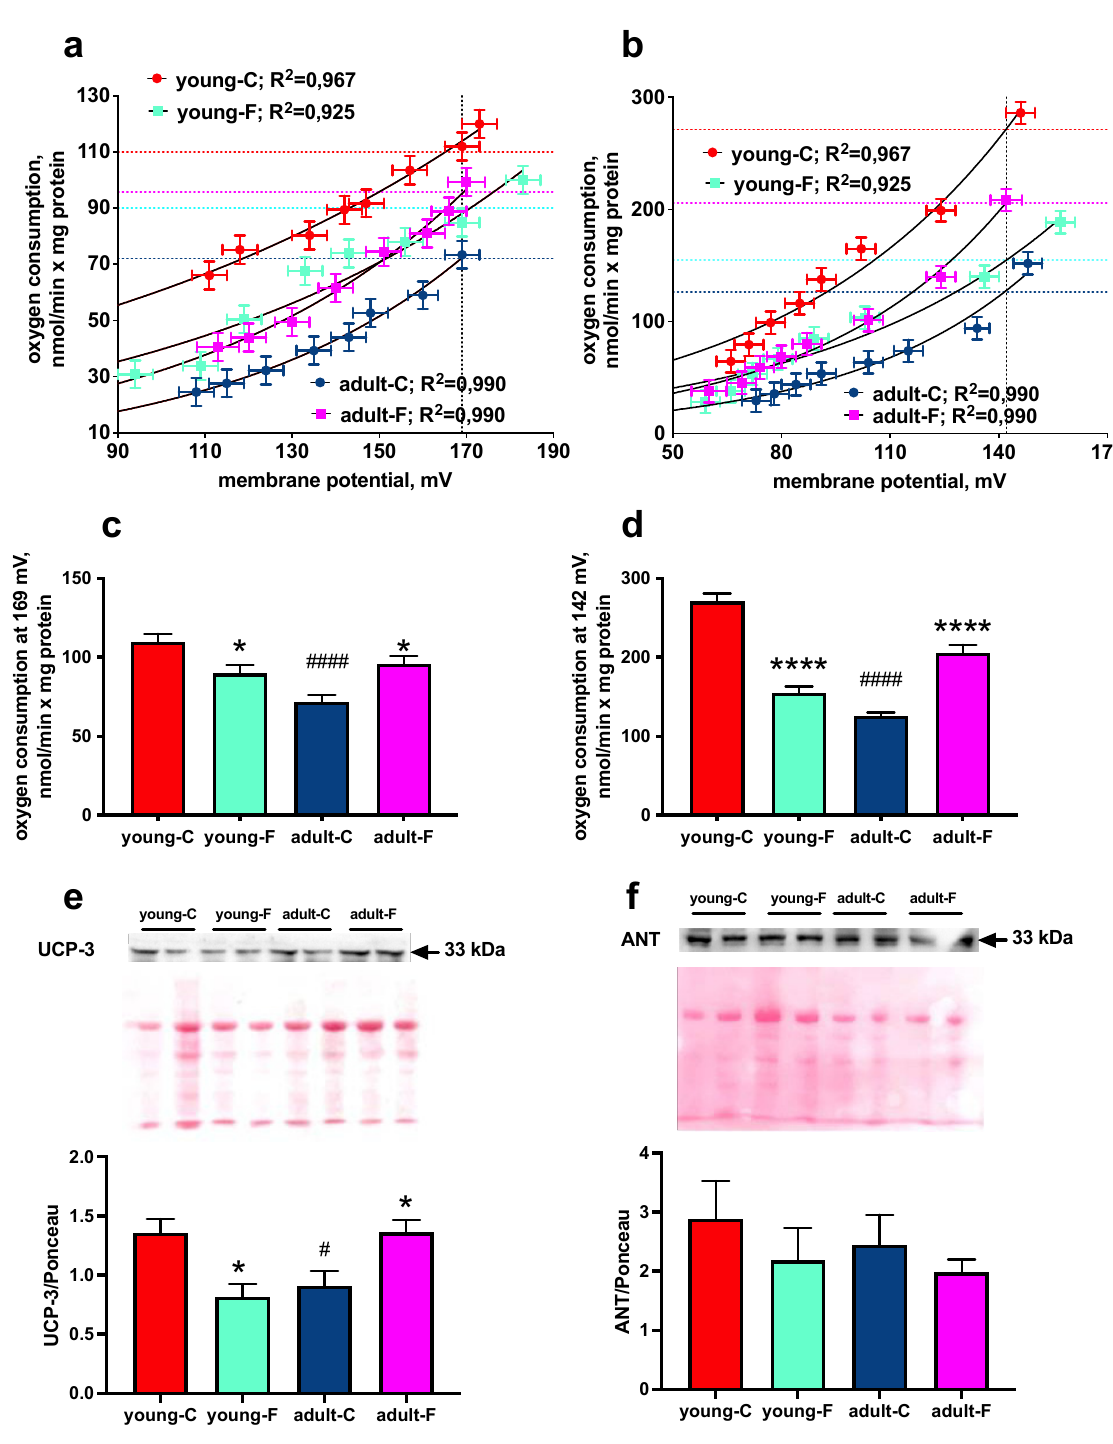
Figure 6. Mitochondrial proton leak. ( a ) Basal and ( b ) palmitate-induced proton leak kinetics, ( c , d ) oxygen consumption at the highest common membrane potential, ( e ) Western blot quantification via Ponceau staining (with representative Western blots) of UCP-3 and ( f ) ANT in isolated mitochondria from skeletal muscles of young and adult rats fed a control (young-C and adult-C) or fructose-rich diet (young-F and adult-F) for 2 weeks. Values are the means ± SEM of eight different rats. * p < 0.05, **** p < 0.0001, compared to respective controls; # p < 0.05, #### p < 0.0001 compared to young-C rats (two-way ANOVA followed by Tukey post-test).